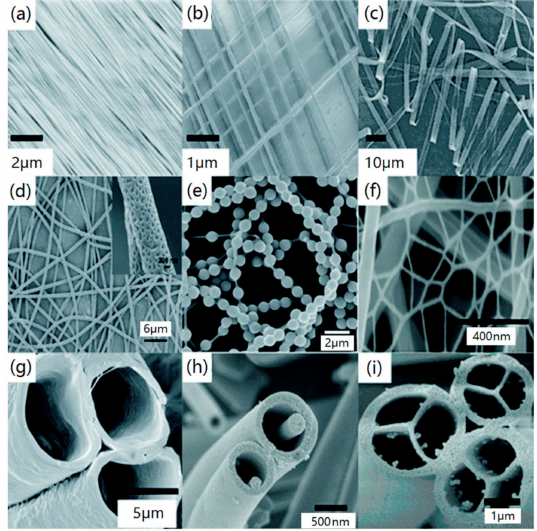
Figure 6. Different images of electrospun nanofibers by SEM: ( a ) unidirectional arranged; ( b ) crosswise arranged; ( c ) ribbon; ( d ) porous fibers; ( e ) necklace-like; ( f ) nanowebs; ( g ) hollow; ( h ) nanowire-in-microtube; ( i ) multichannel tubular. (Reproduced with permission from reference